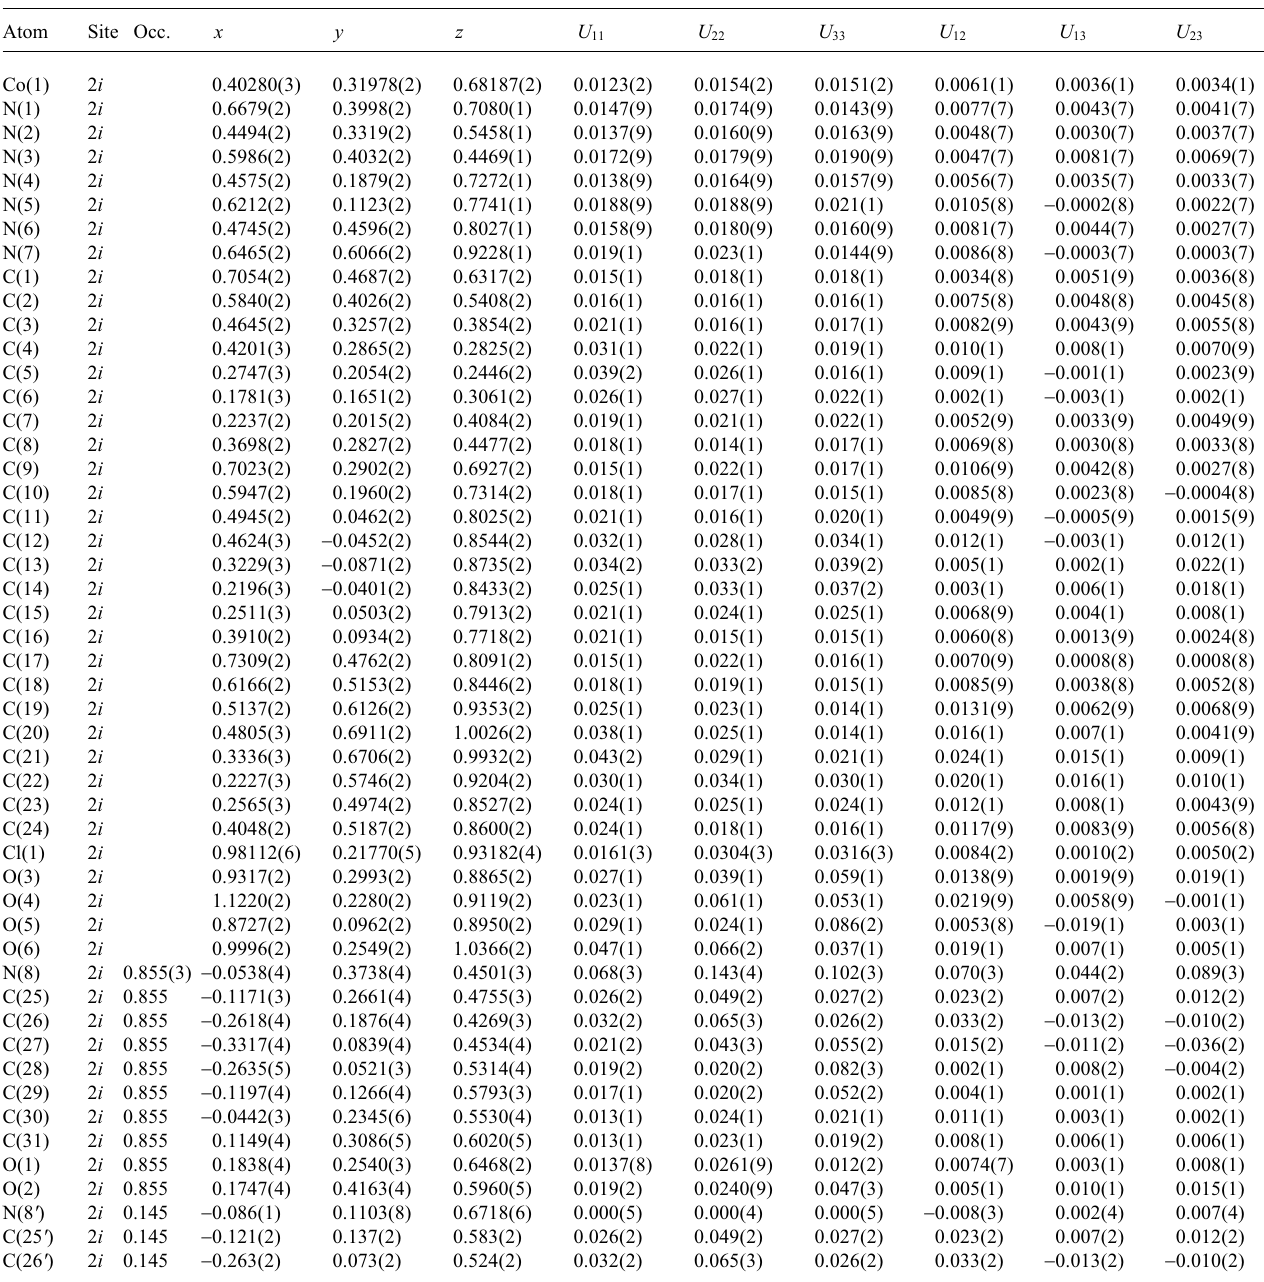
Table 3. Atomic coordinates and displacement parameters (in Å 2